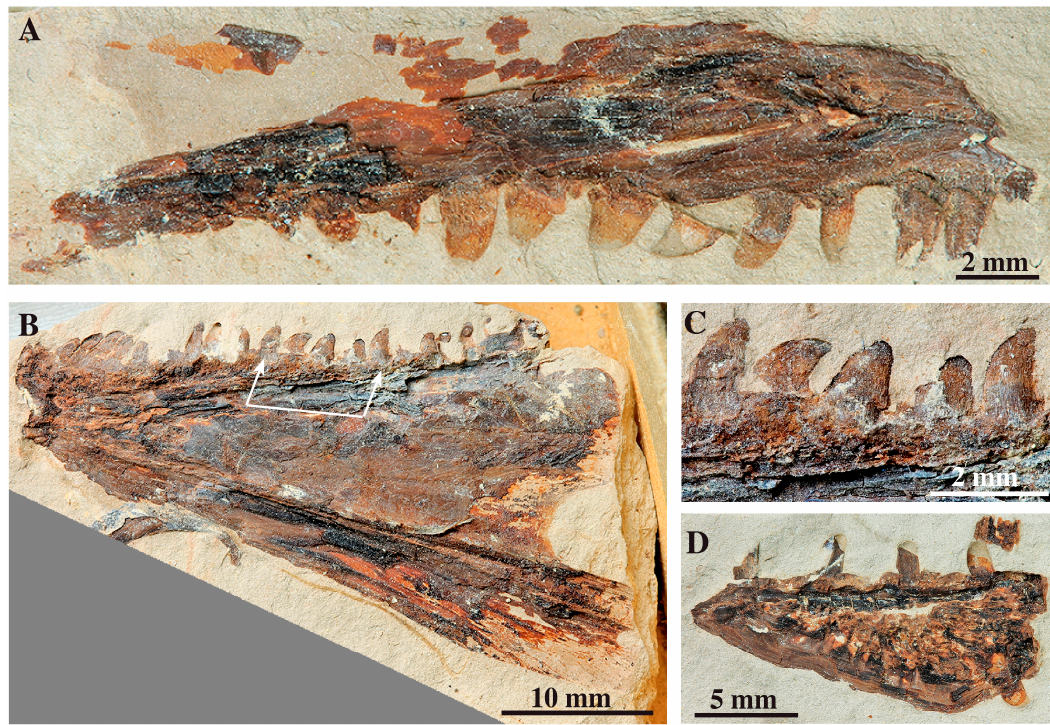
Figure 4. Bannockburn Formation, Lake Manuherikia, early Miocene. ( A – D ), Bannockburn Inlet, Galaxias n. sp. ‘Bannockburn Inlet’. ( A ), Premaxilla (OU22617); ( B ), Fragment of dentary (OU22665); ( C ), Close-up of B, showing uniserial, stout, bluntly-pointed, curved teeth (OU22664); ( D ), Fragment of dentary (OU22664).